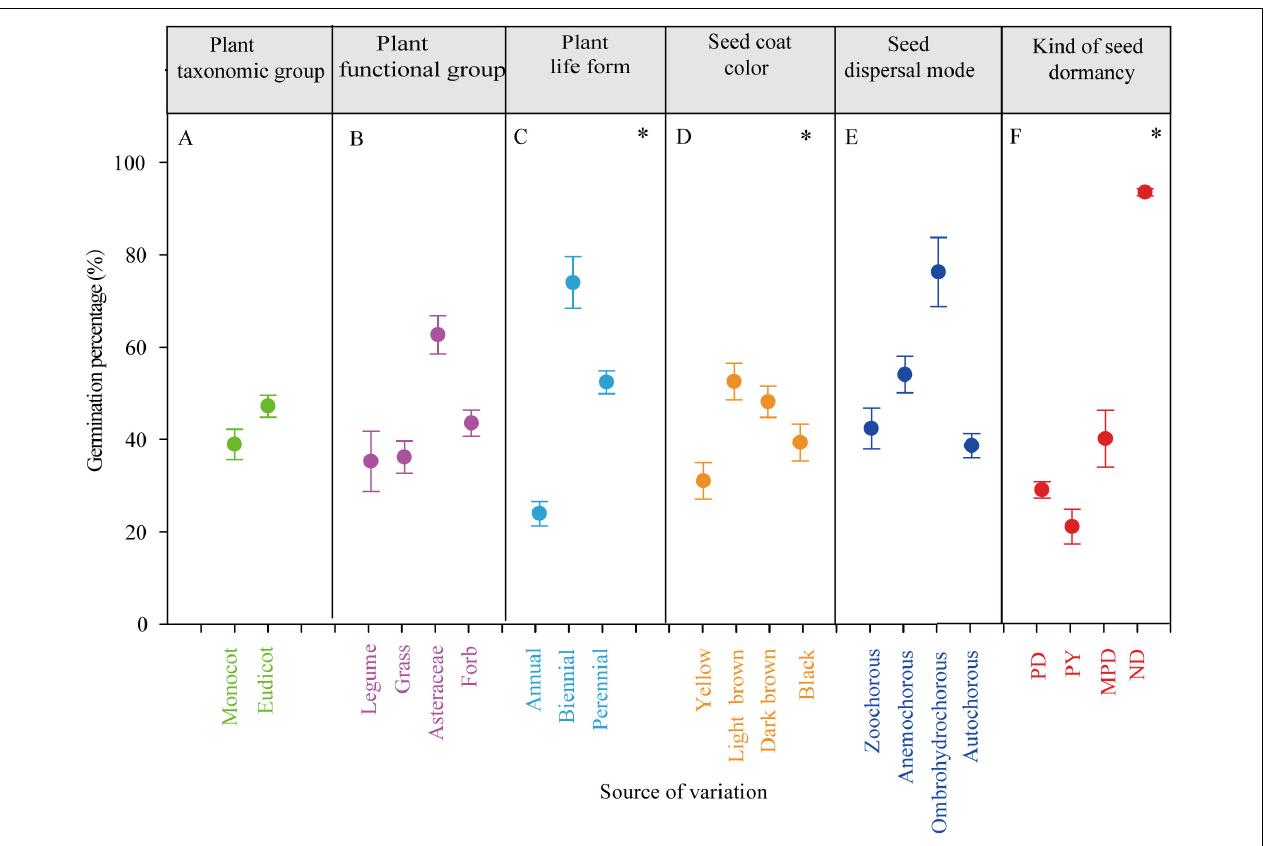
FIGURE 1 | The effects of plant taxonomic group (A) , plant functional group (B) , plant life form (C) , seed coat color (D) , seed dispersal mode (E) , and kind of seed dormancy (F) on germination percentage. PD, physiological dormancy; PY, physical dormancy; MPD, morpho-physiological dormancy; ND, non-dormancy. ∗ P <